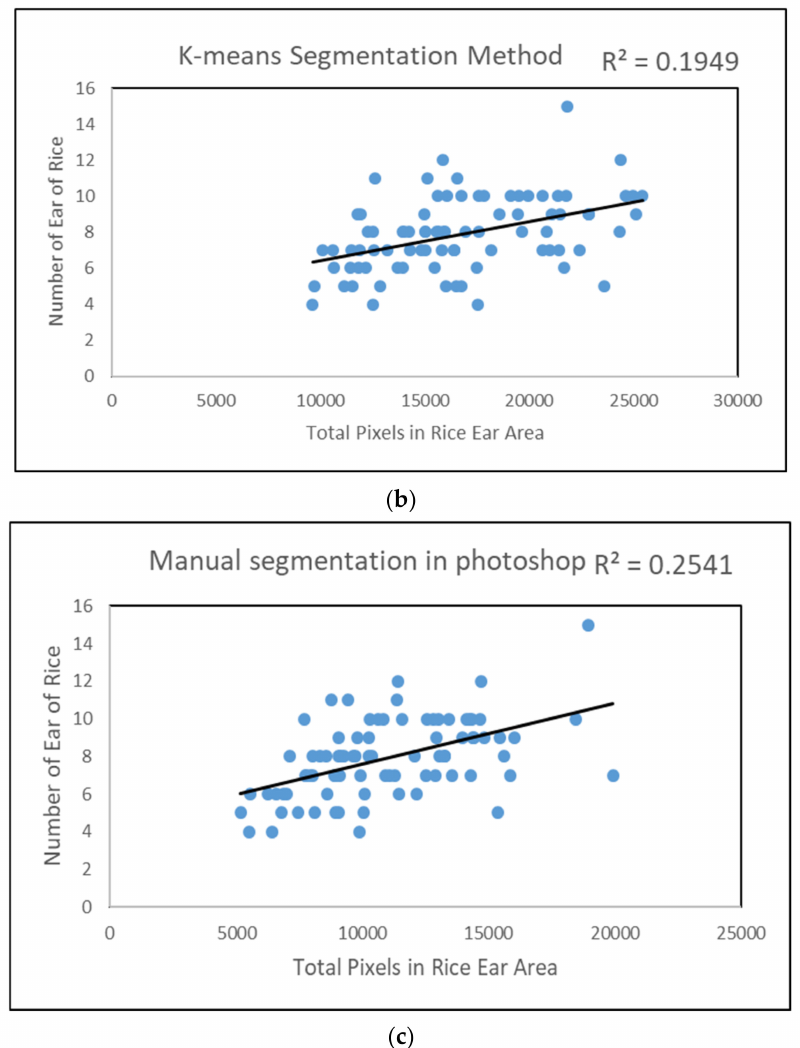
Figure 9. Prediction accuracy of the rice ears number with its total pixel value: ( a ) SVM segmentation method; ( b ) K-means segmentation method; ( c ) manual segmentation in